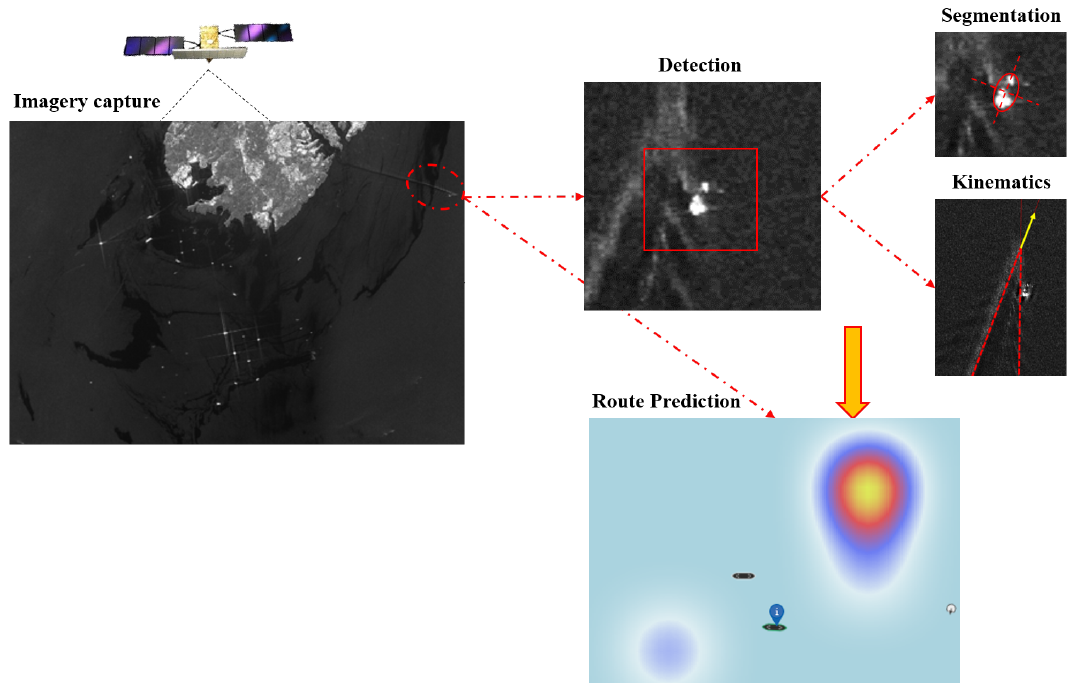
Figure 1. Visual representation of the multiple software tasks in the implemented platform and their